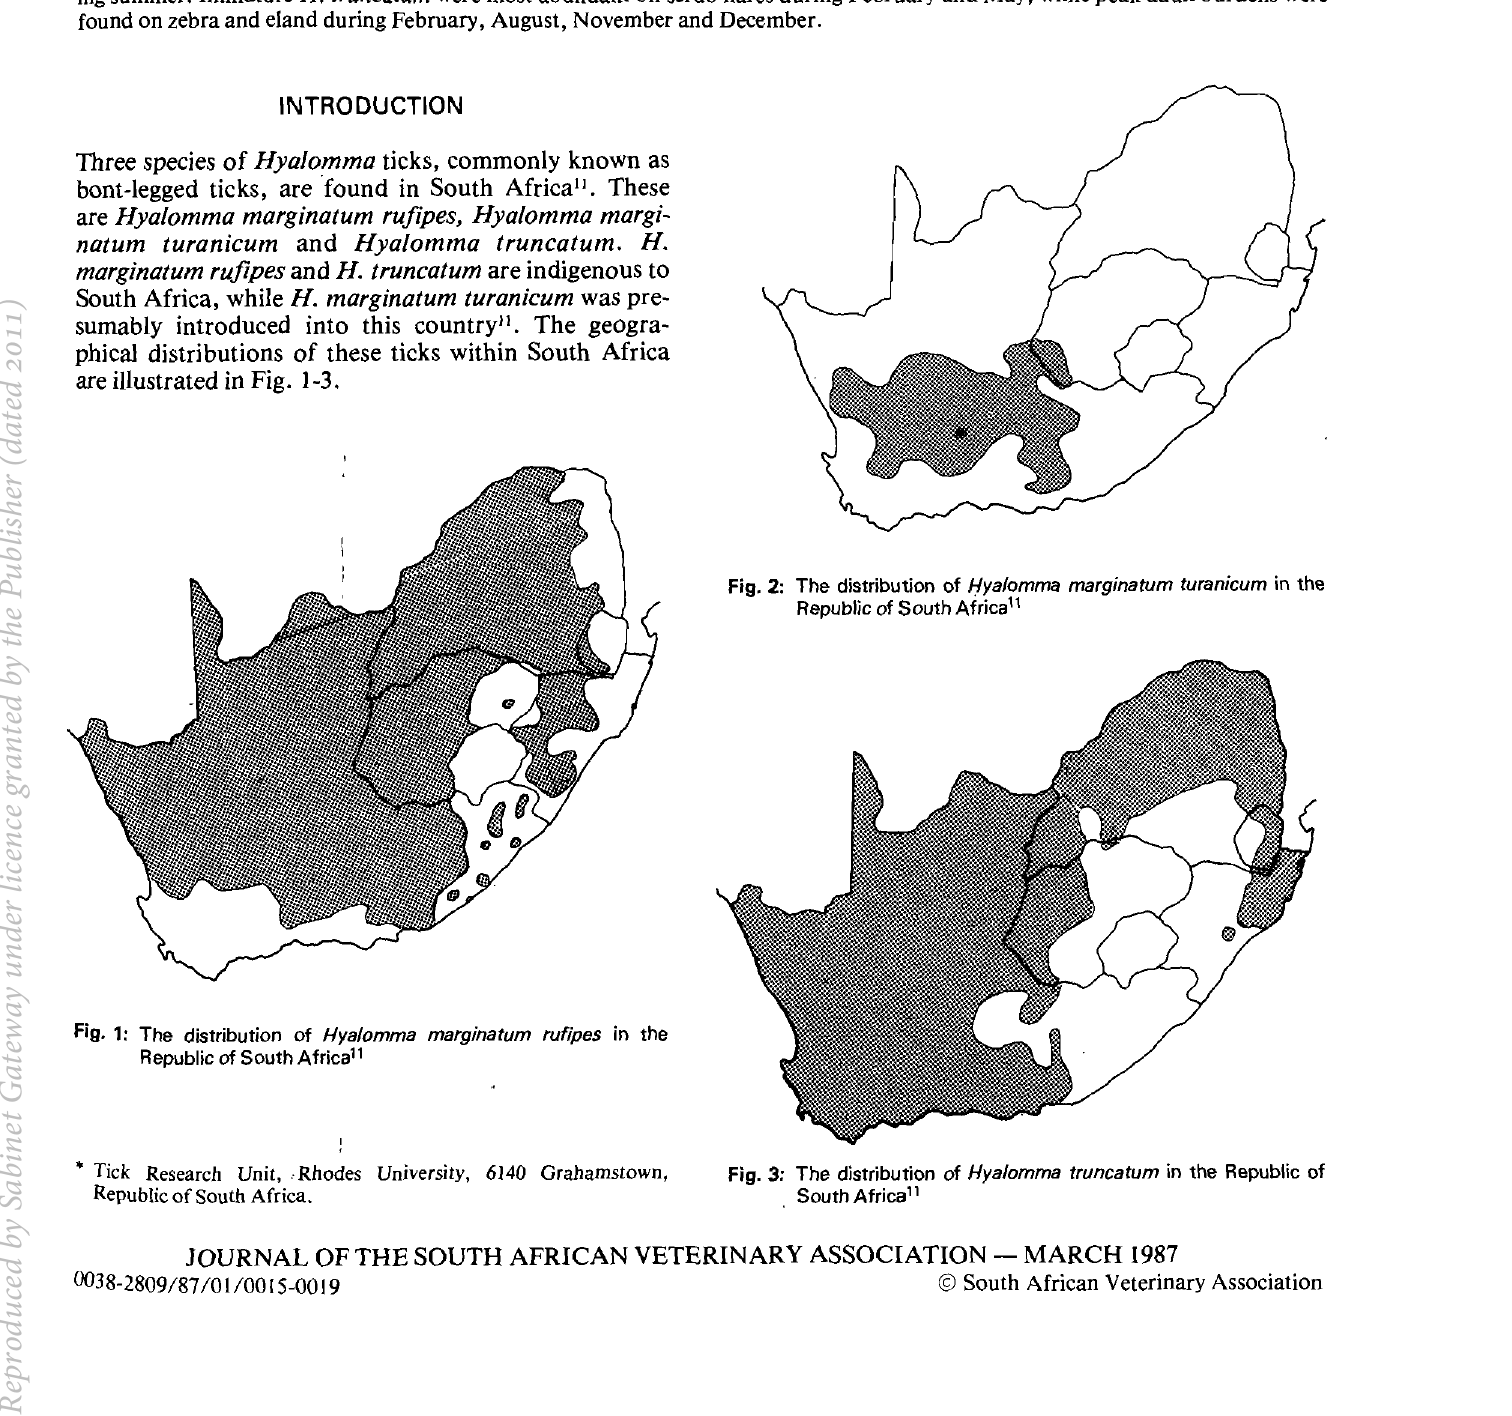
Fig. 3; The distribution of Hyalomma truncatum in the Republic of , South Africa